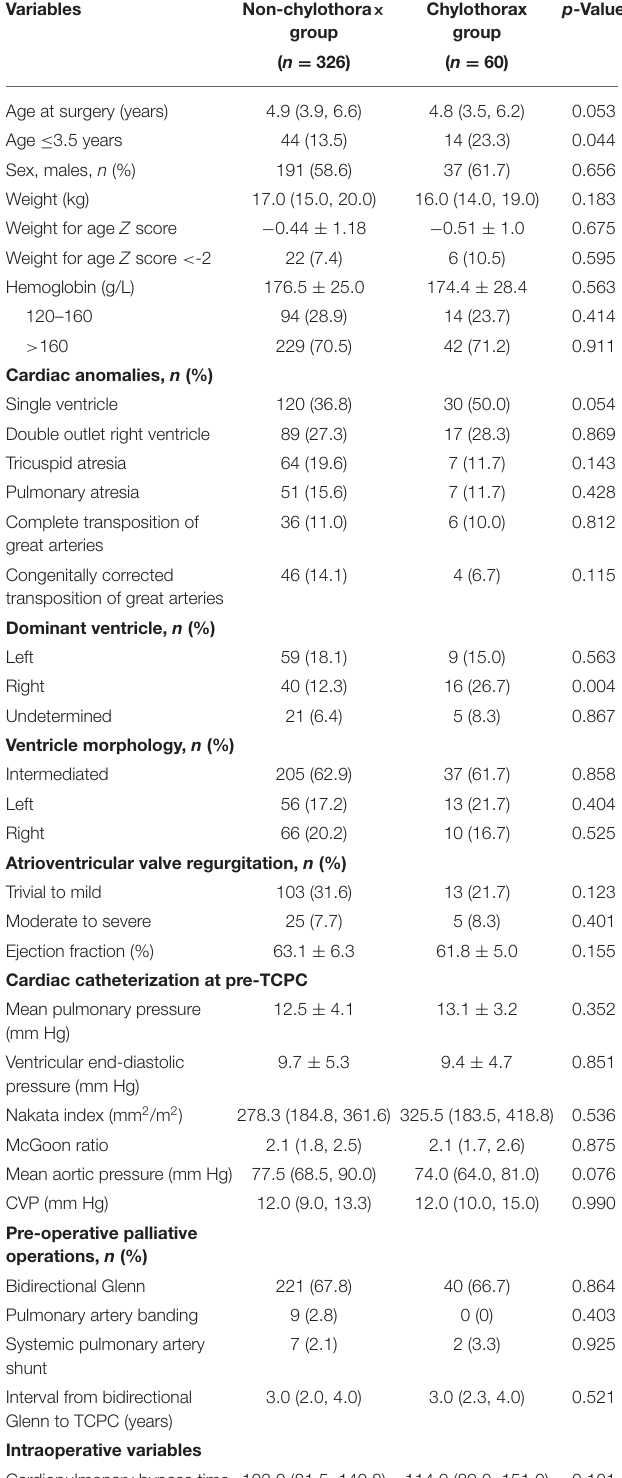
TABLE 1 | Characteristics of patients with and without chylothorax after TCPC operation.